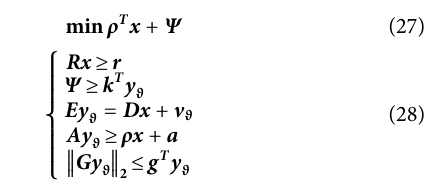
TABLE 3 Uncertain adjustment parameter setting.